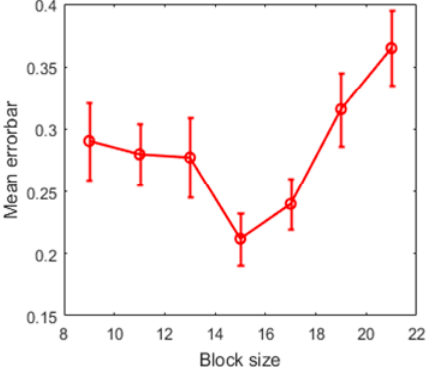
Figure 8. The mean error-bars of di ff erent block sizes. Thus, when the block size N = 15, the proposed algorithm has an overwhelming advantage for its accuracy and stability.